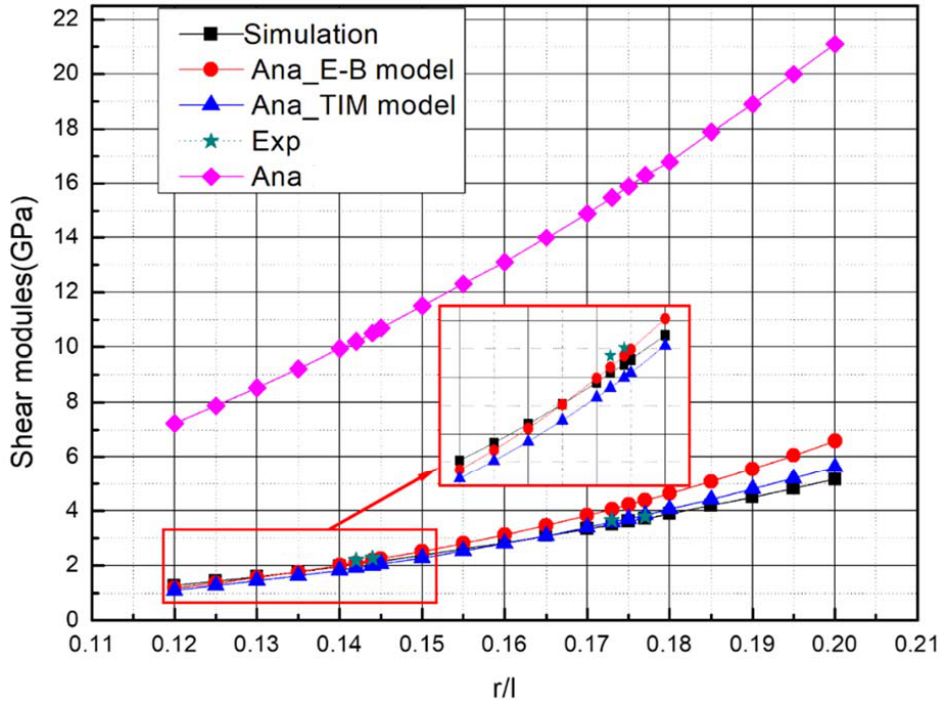
Figure 15. The curve of the shear modulus versus the slenderness ratio (slenderness ratio (r/l) = 0.12~0.2) of cubic sandwich BCC lattice